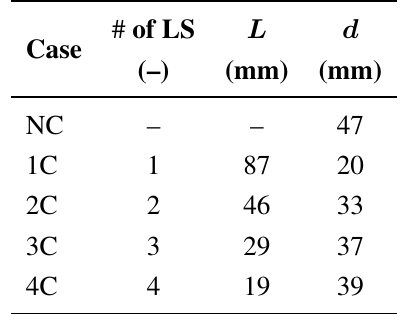
Figure 8. Foam samples: ( a ) NC; ( b ) 1C; ( c ) 2C; ( d ) 3C; ( e ) 4C. Table 2. Overview of experimental sample